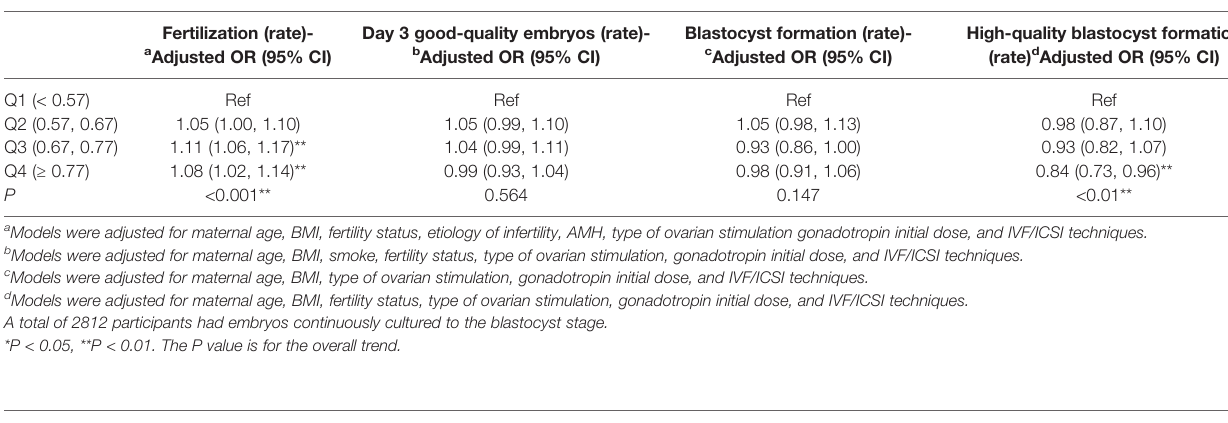
TABLE 3 | Associations of OS/FP with ovarian response (N = 6110). Number of retrieved oocytes a (n) Adjusted RR (95% CI) Q1 (<0.57)